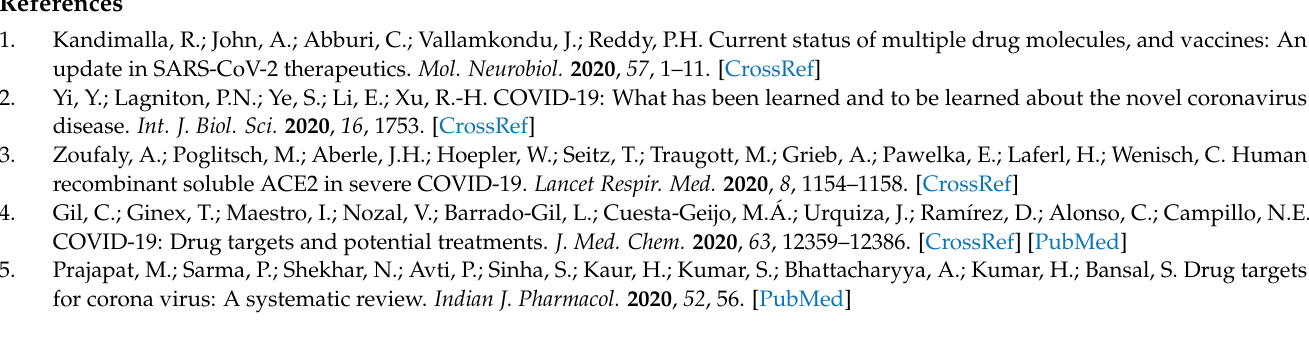
Supplementary Materials: The following are available online: Figure S1: Reported model for Mpro inhibitors through Pharmacophore modeling